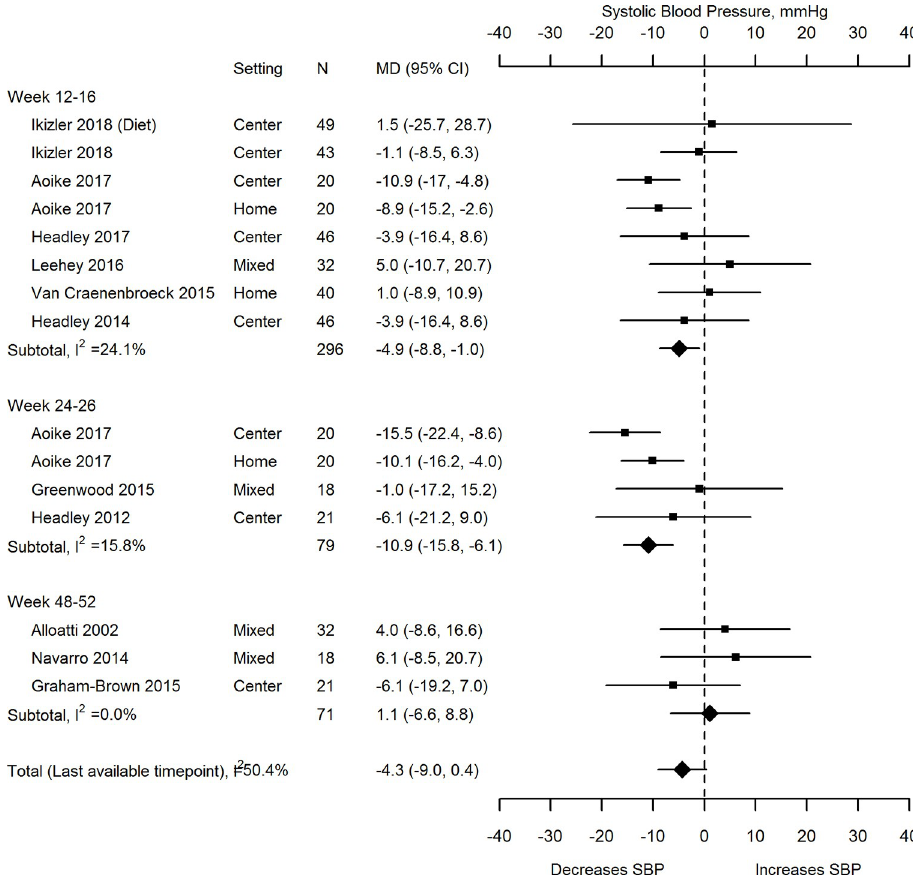
Fig 2. Effects of exercise on non-ambulatory systolic blood pressure: Exercise versus no intervention. CI confidence interval, DBP diastolic blood pressure, MD mean difference, N number of participants, SBP systolic blood pressure.